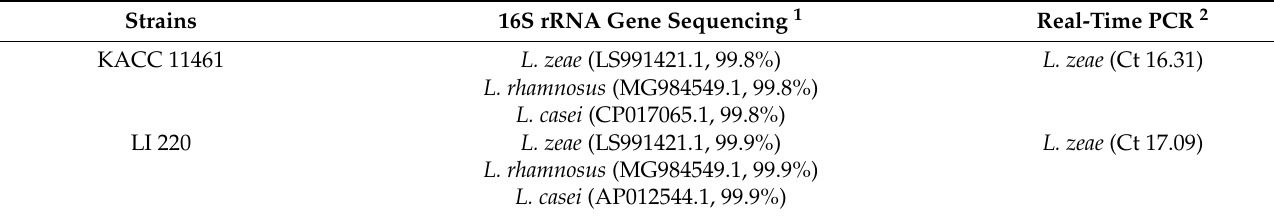
Table 4. Comparison of 16S rRNA gene sequencing and real-time